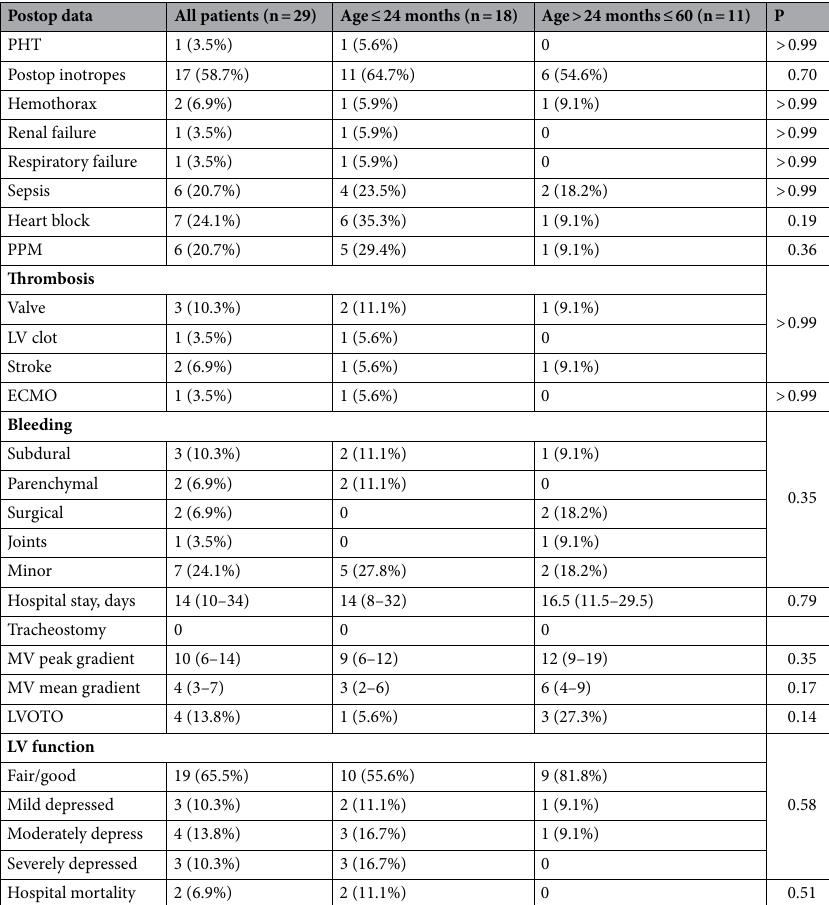
Table 2. Postoperative outcomes. ECMO extracorporeal membrane oxygenation, LV left ventricle, LVOTO left ventricular outflow tract obstruction, PHT pulmonary hypertension, MV mitral valve, PPM permanent pacemaker.